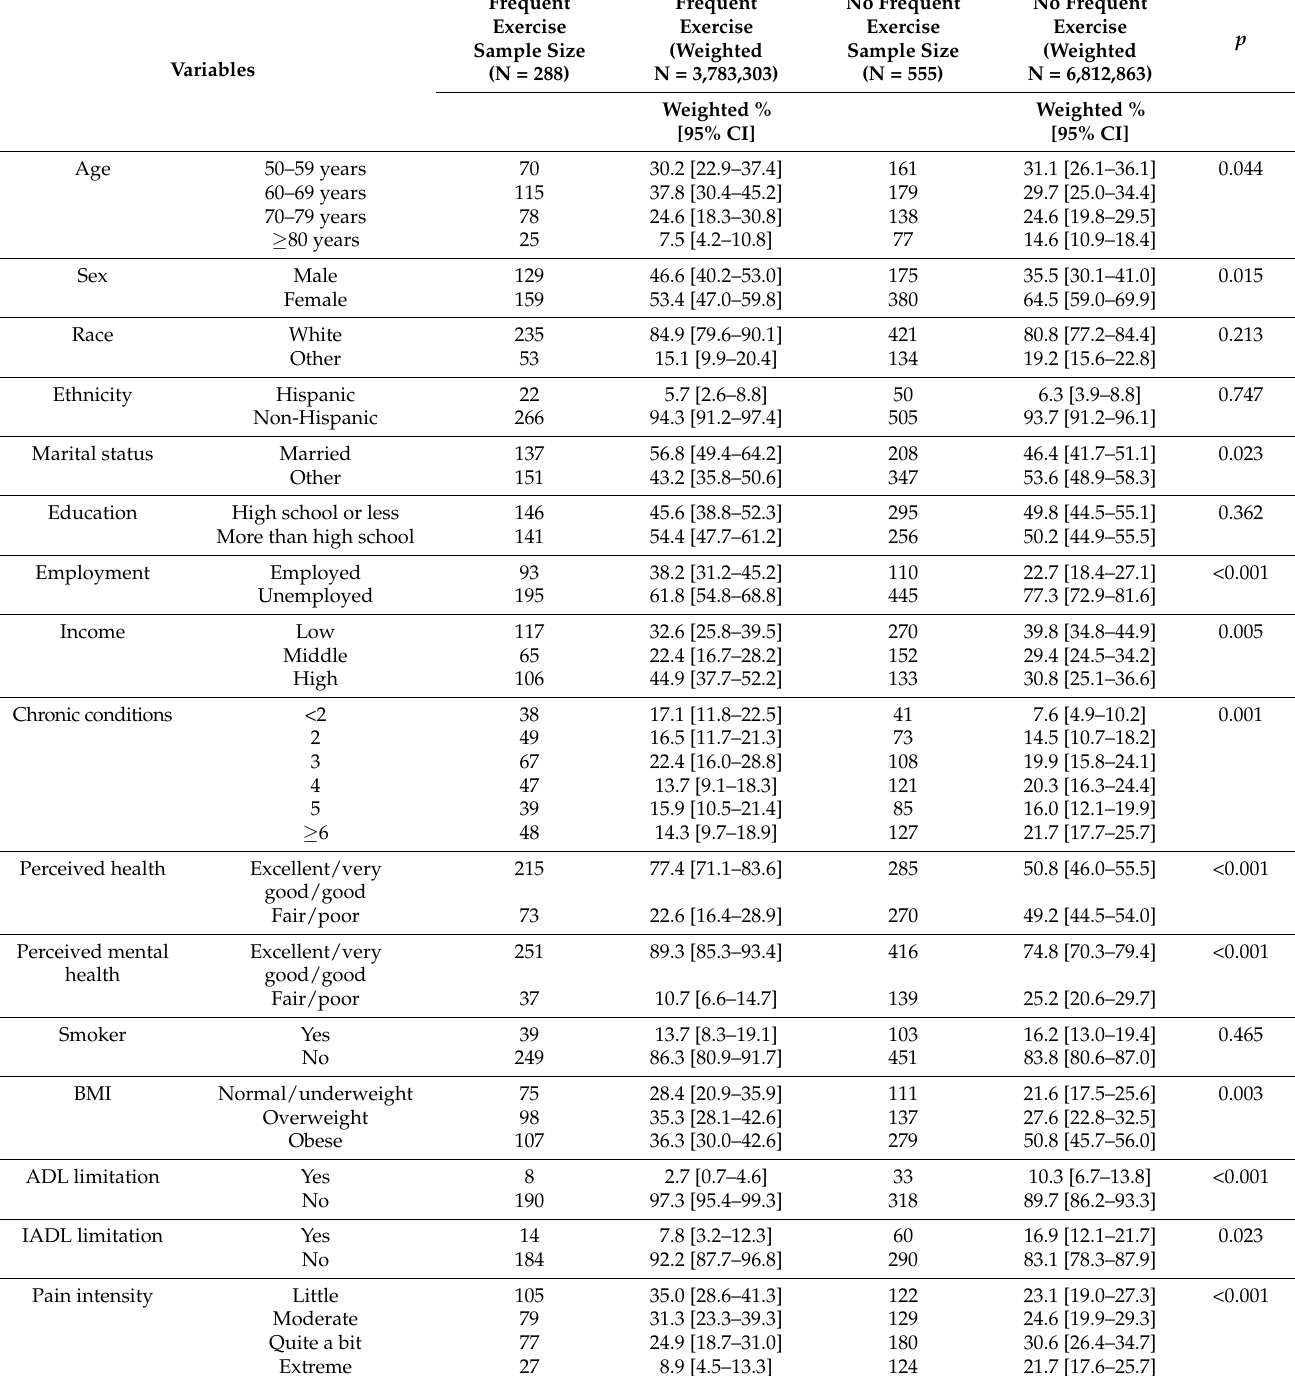
Table 1. Characteristics of United States adults aged ≥ 50 years with self-reported pain in the past four weeks who used opioids stratified by self-reported exercise (frequent exercise versus no frequent exercise) in the 2020 Medical Expenditure Panel Survey (Weighted N =